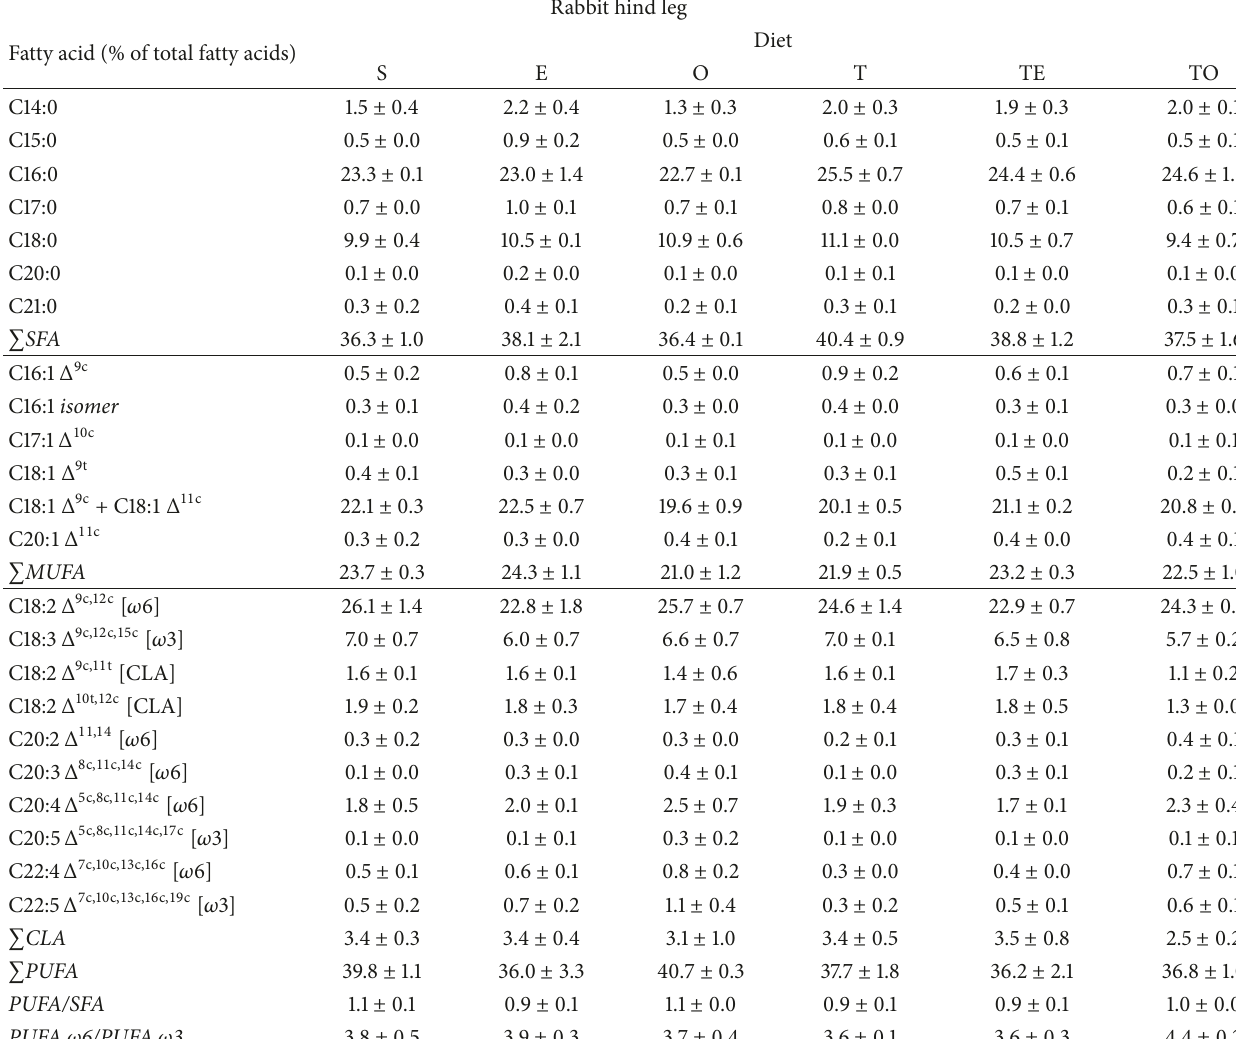
Table 5: Fatty acid composition of rabbit hind leg belonging to different dietary groups. Rabbit hind